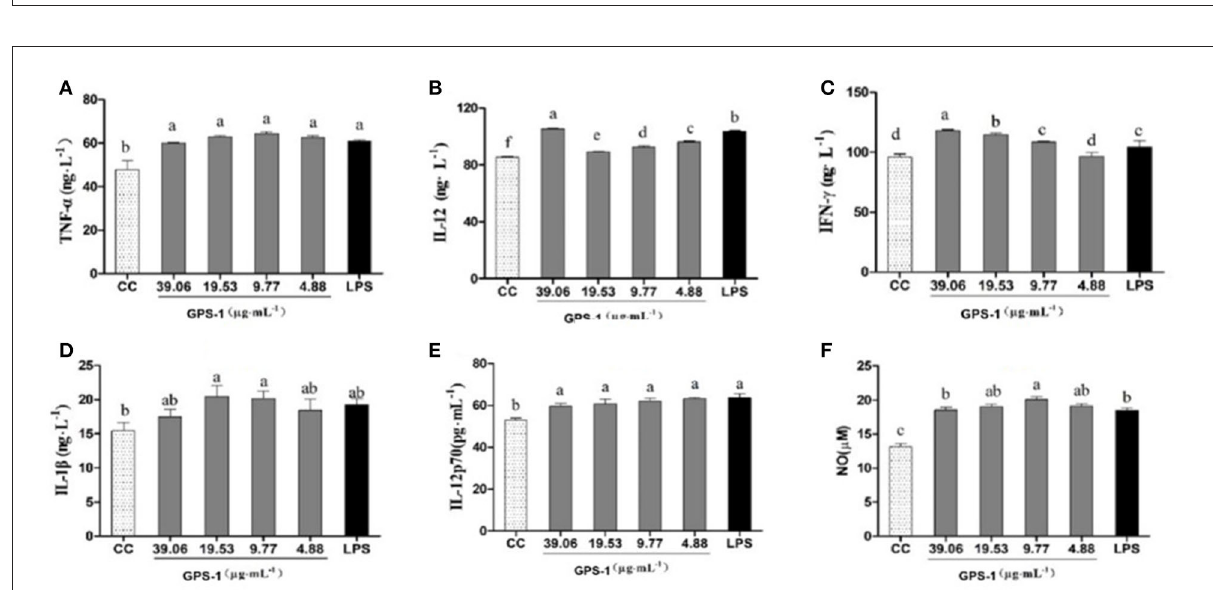
FIGURE4 Effects of GPS-1 on the secretion of NO (F) , and cytokines (A–E) by DCs. (A) TNF- α ; (B) IL-12; (C) IFN- γ ; (D) IL-1 β ; (E) IL-12p70; (F) NO. a − f Values in the same column with different superscript letters differ significantly at p < 0.05.